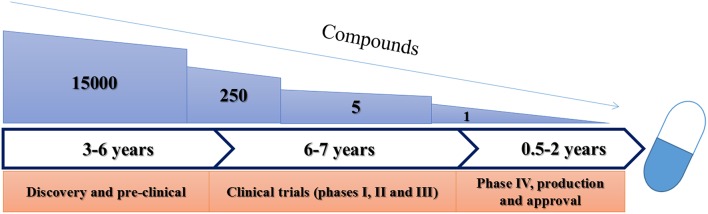
Schematic representation of current FDA approval procedures for anti-infective drugs.